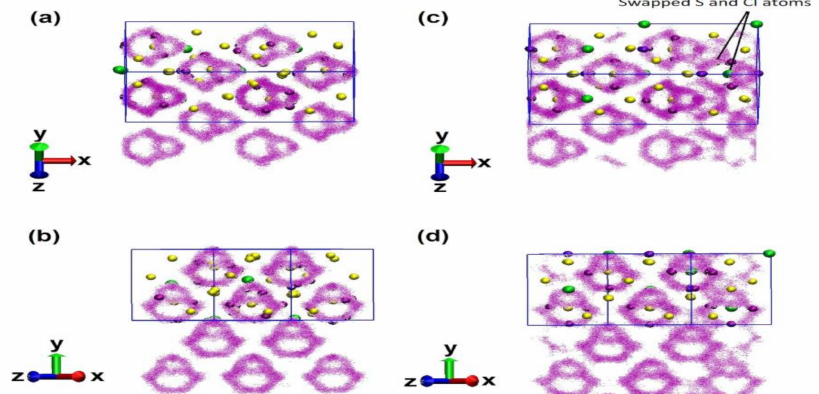
Figure 5. Li ion trajectories views, pure Li 6 PS 5 Cl ( a , b ) and ( c , d ) for S-Cl disarrayed Li 6 PS 5 Cl at 600 K observed up to 50 ps. Li (violet), S (yellow), Cl (green) and P (light purple). The diffusion pathways of Li-ions = small violet dots. The apertures illustrate simulation supercell. Adapted from Baktash et al.